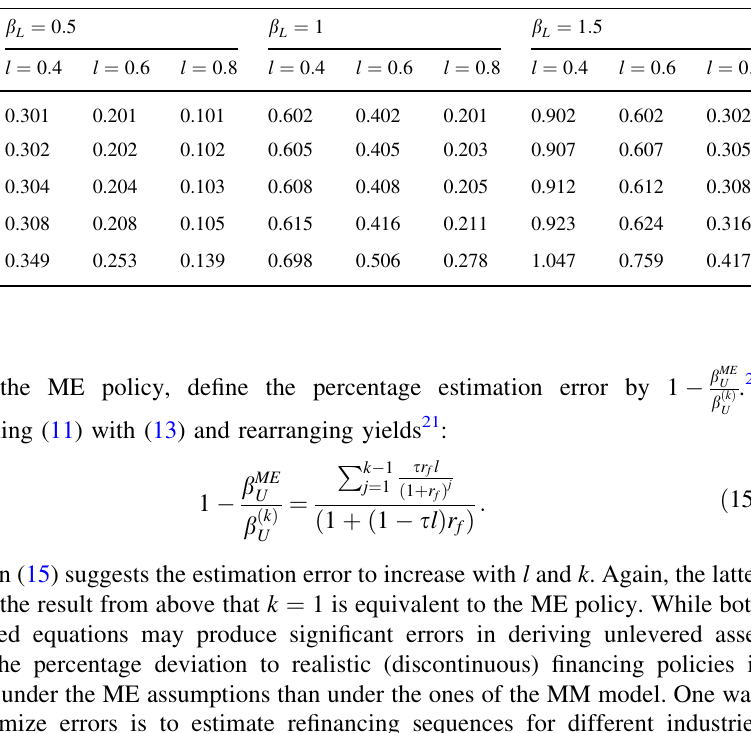
Table 1 Comparison of unlevering